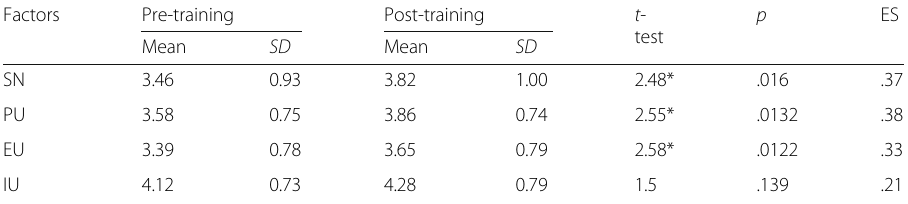
Table 6 Descriptive Statistics and t -test Results for Technology-adoption Variables Factors Pre-training Post-training